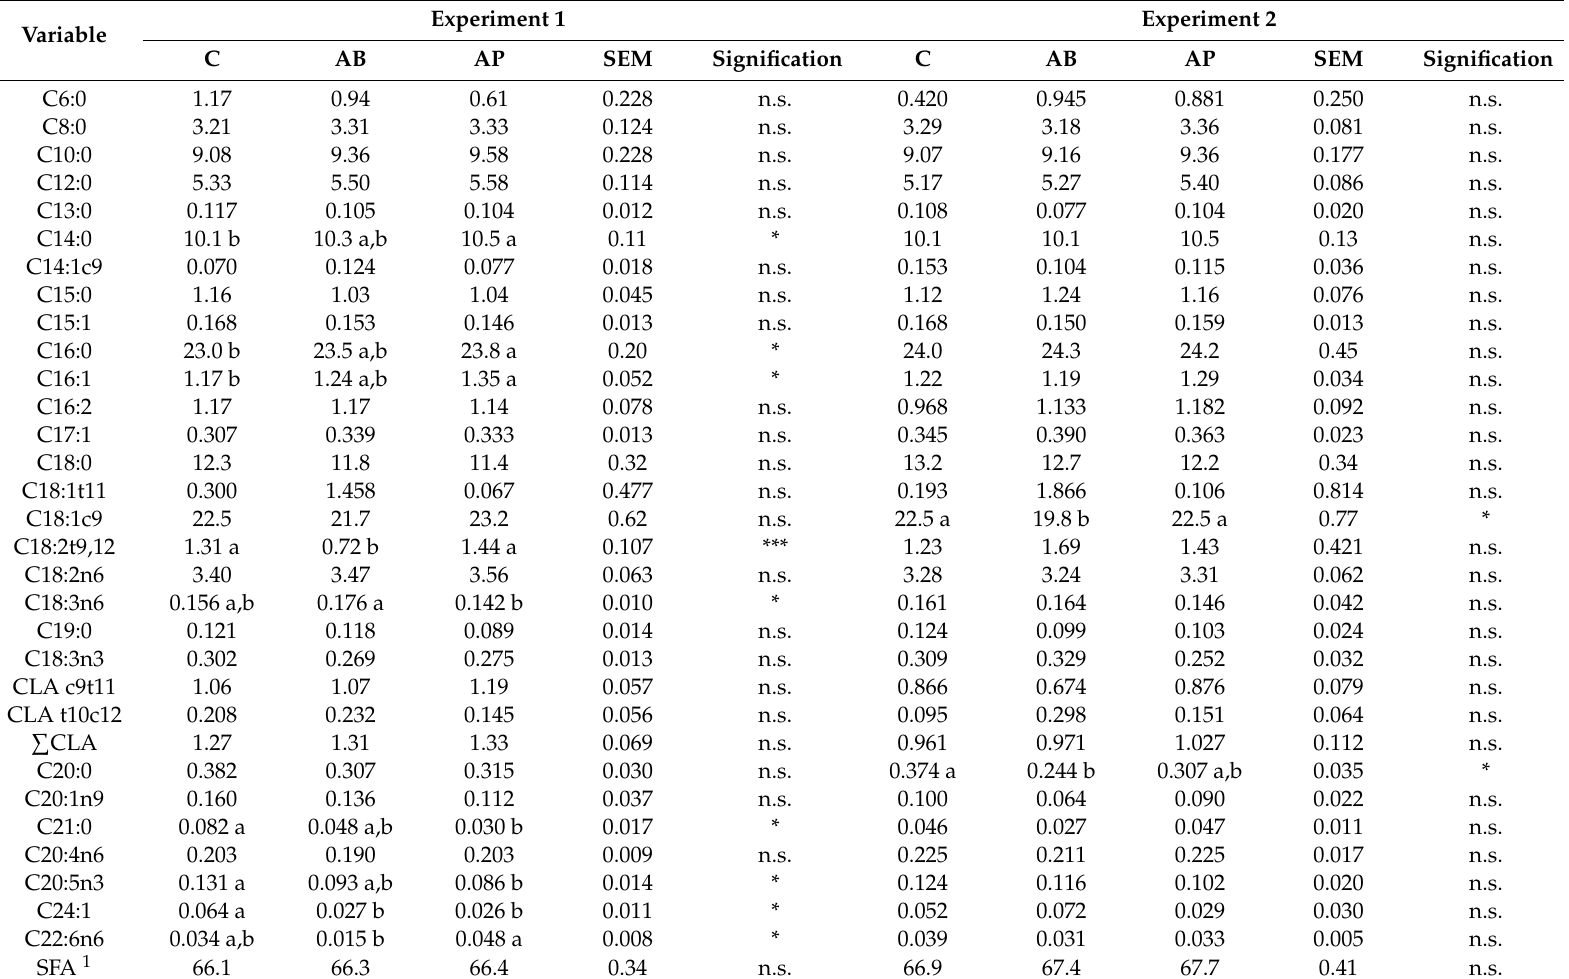
Table 5. E ff ect of the diet on milk fatty acid profile (g / 100 AGT) in Experiments 1 and 2.